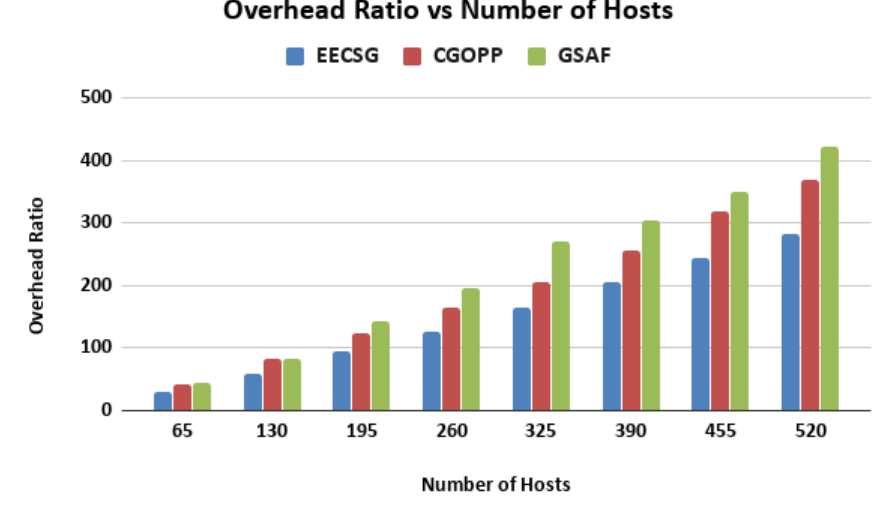
Figure 5. Overhead ratio vs. number of